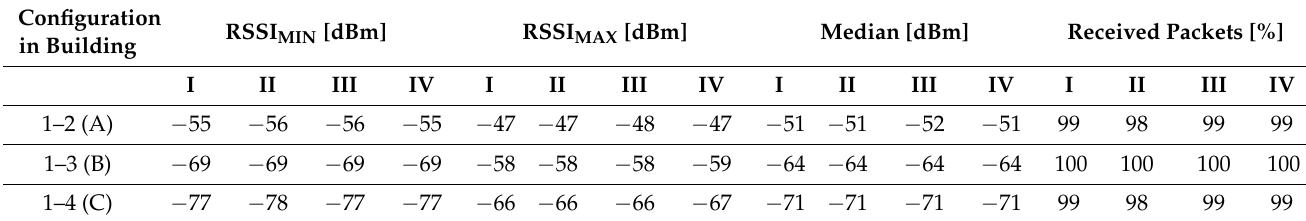
Table 1. RSSI and received packets test results for the four cases.